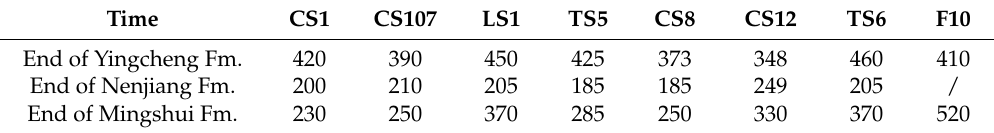
Table 2. Erosion thicknesses of individual wells in the Changling Depression (unit: m). Time CS1 CS107 LS1 TS5 CS8 CS12 TS6 F10 End of Yingcheng Fm. 420 390 450 425 373 348 460 410 End of Nenjiang Fm. 200 210 205 185 185 249 205 / End of Mingshui Fm. 230 250 370 285 250 330 370 520